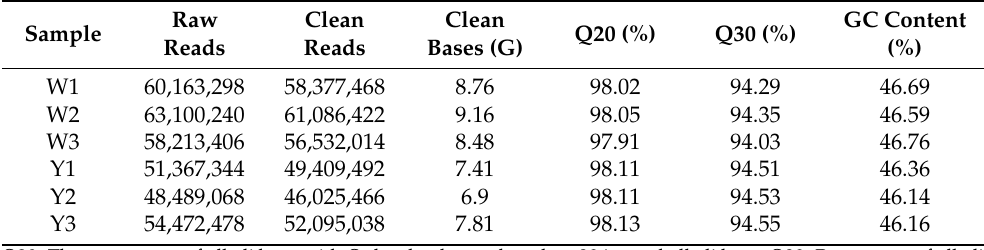
Table 1. Clean reads data quality